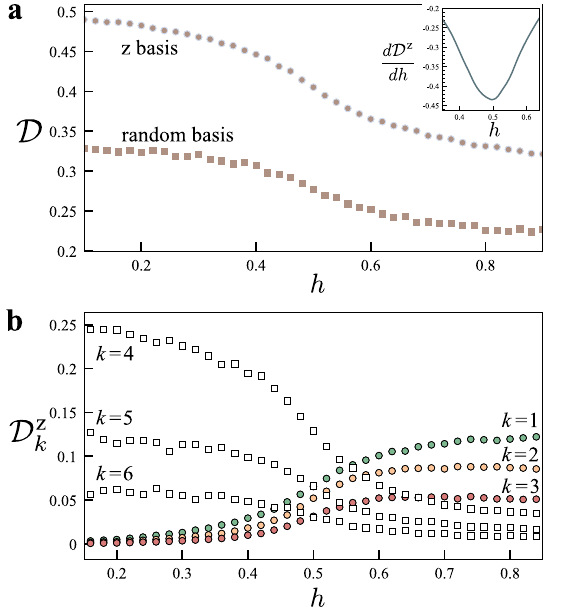
Fig. 6 Ising model results. a Dissimilarity of the Ising model ground state as a function of the transverse magnetic fi eld in the σ z and the random bases; the inset shows derivative of the dissimilarity in the σ z basis at σ z basis with respect to h . b Partial dissimilarities D k in the different coarse-graining steps k = 1 … 6. The global change in the trend between k = 3 and k = 4 is related to the coarse-graining window reaching the size of the system, Λ k = N , so that the averaging starts mixing different bitstrings.